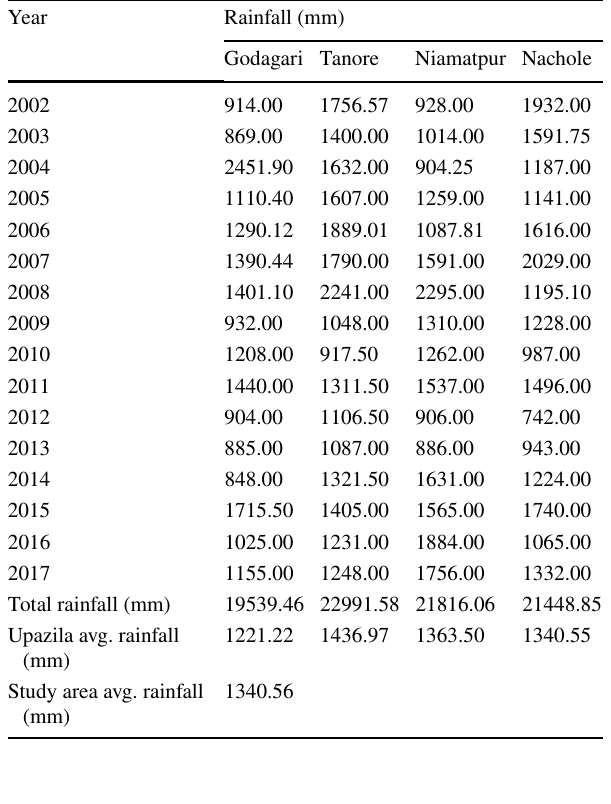
Table 1 Annual average rainfall of the study area Year